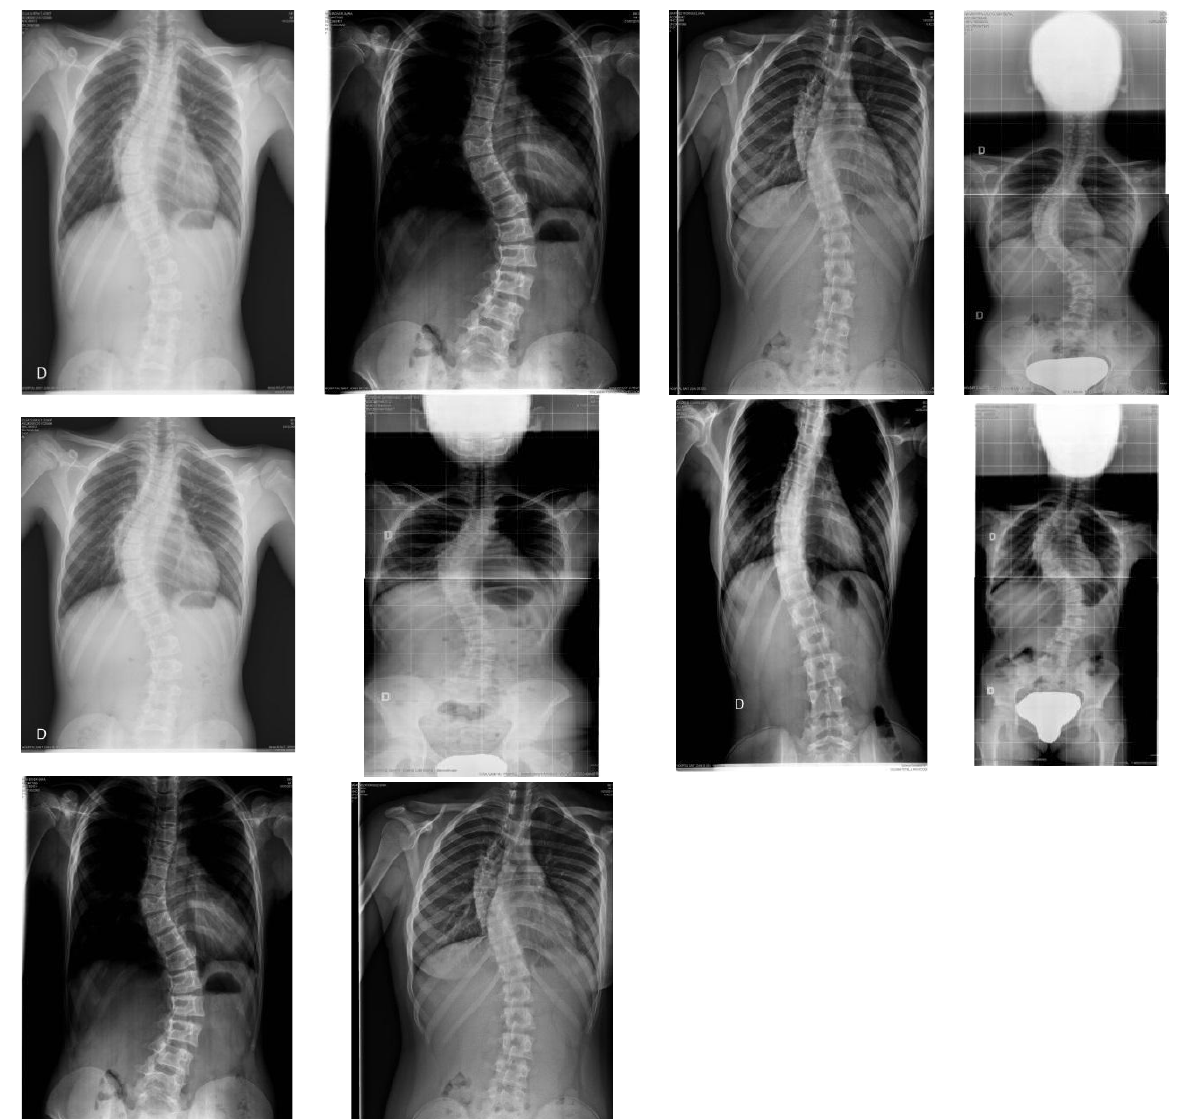
Figure 1. X-ray of the 14 participants who required surgery.